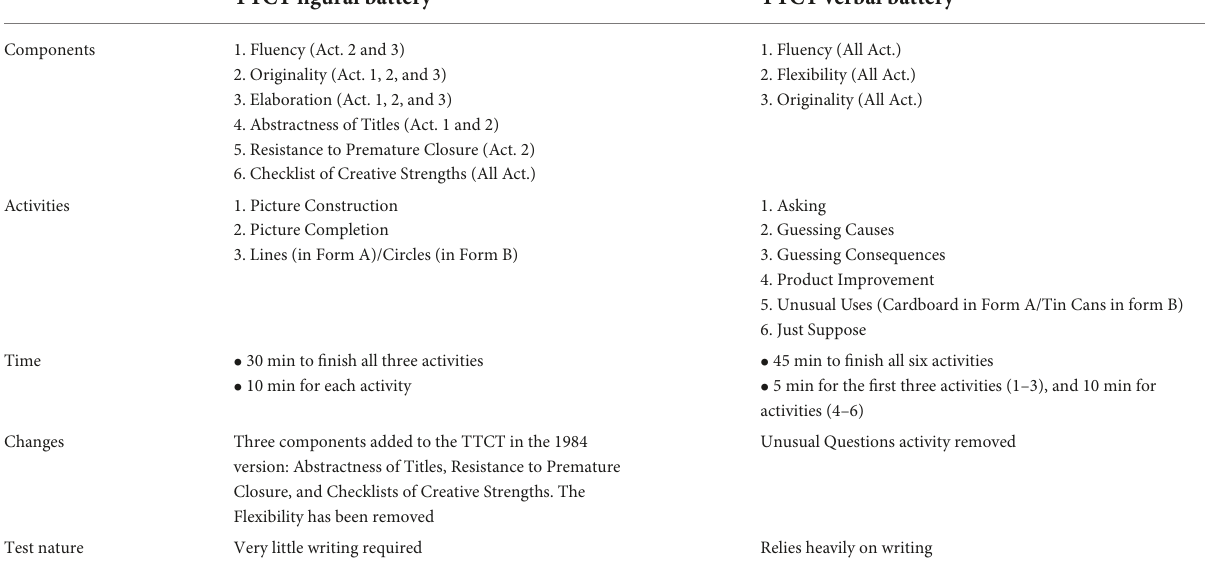
TABLE 1 A comparison between figural and verbal forms of the Torrance Tests of Creative Thinking (TTCT) according to its components, activities, time, changes, and the test nature. TTCT figural